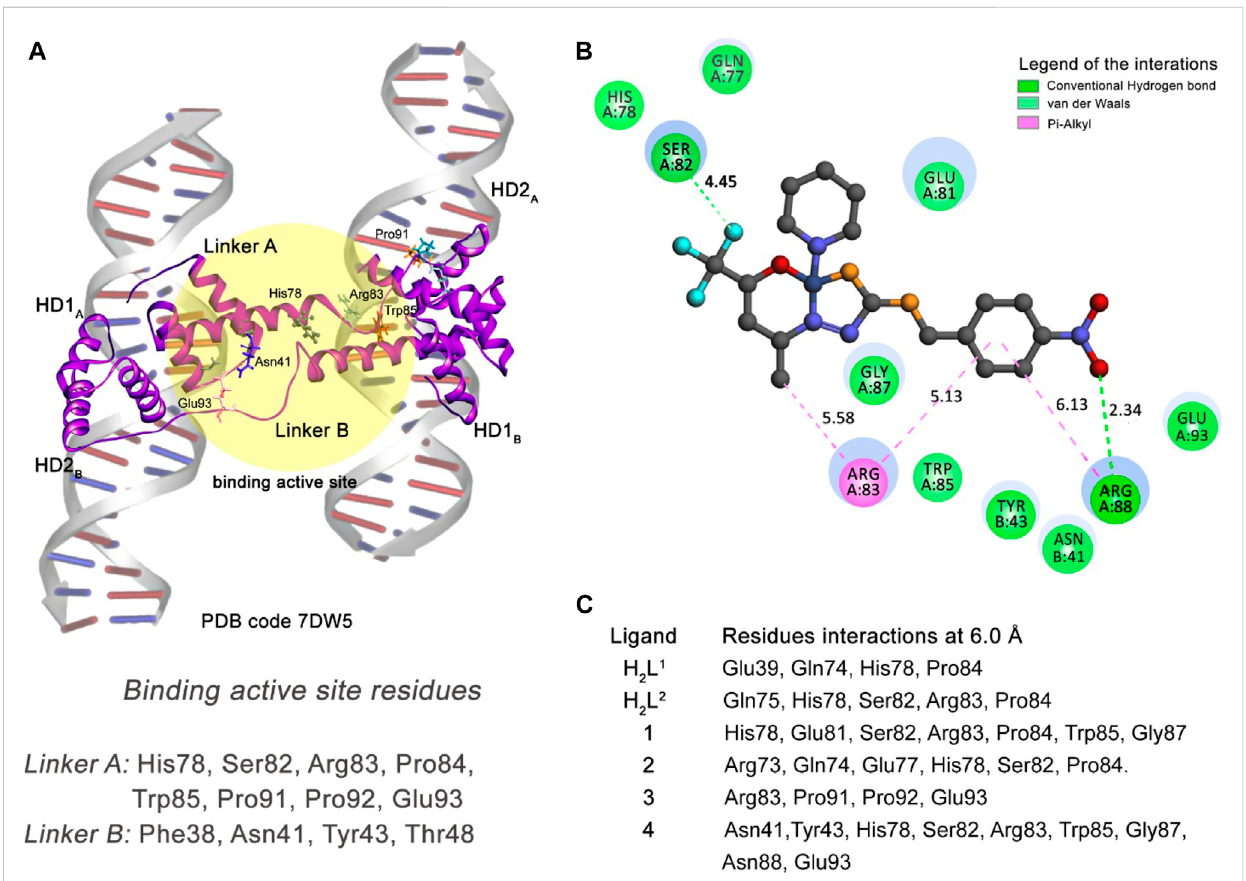
FIGURE 14 Molecular docking results of the 697 cell type target. (A) Binding active site regions of the Linkers A and B of the protein – DNA complex ( 7DW5 ) (Zhang et al., 2021). (B) 2D representation of the interactions carried out between the best-ranked inhibitor, 4, and the active site. (C) Main nearest residues of both active sites of the 7DW5 receptor (distance till 6.0 Å) and all the six compounds